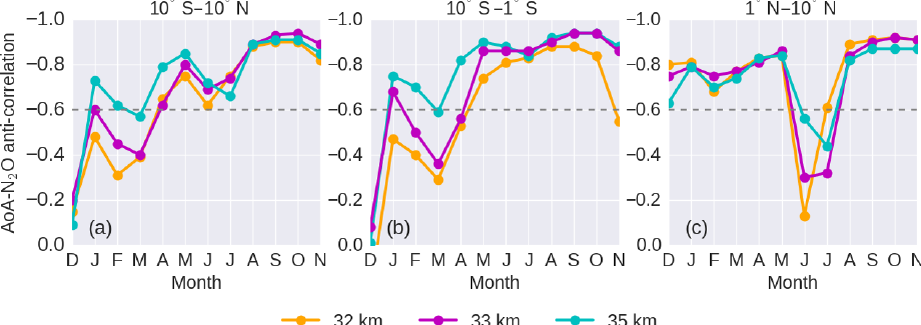
Figure 10. N 2 O–AoA anti-correlation as a function of month averaged for the period January 2004–April 2012 for (a) 10 ◦ S–10 ◦ N, (b) 10– 1 ◦ S, and (c) 1–10 ◦ N. Colour coding indicates altitude: 32km (orange), 33km (magenta), and 35km (cyan). The dashed horizontal lines indicate an arbitrary threshold of moderate correlation, which was selected to be the value of − 0 .